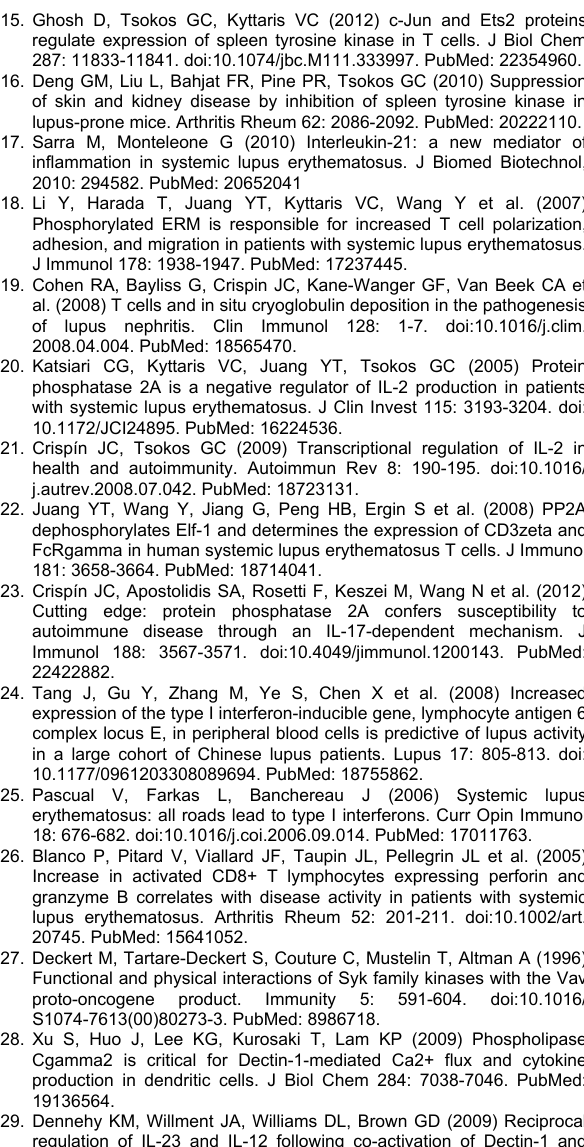
Table S1. Assay characteristics of real-time PCR gene